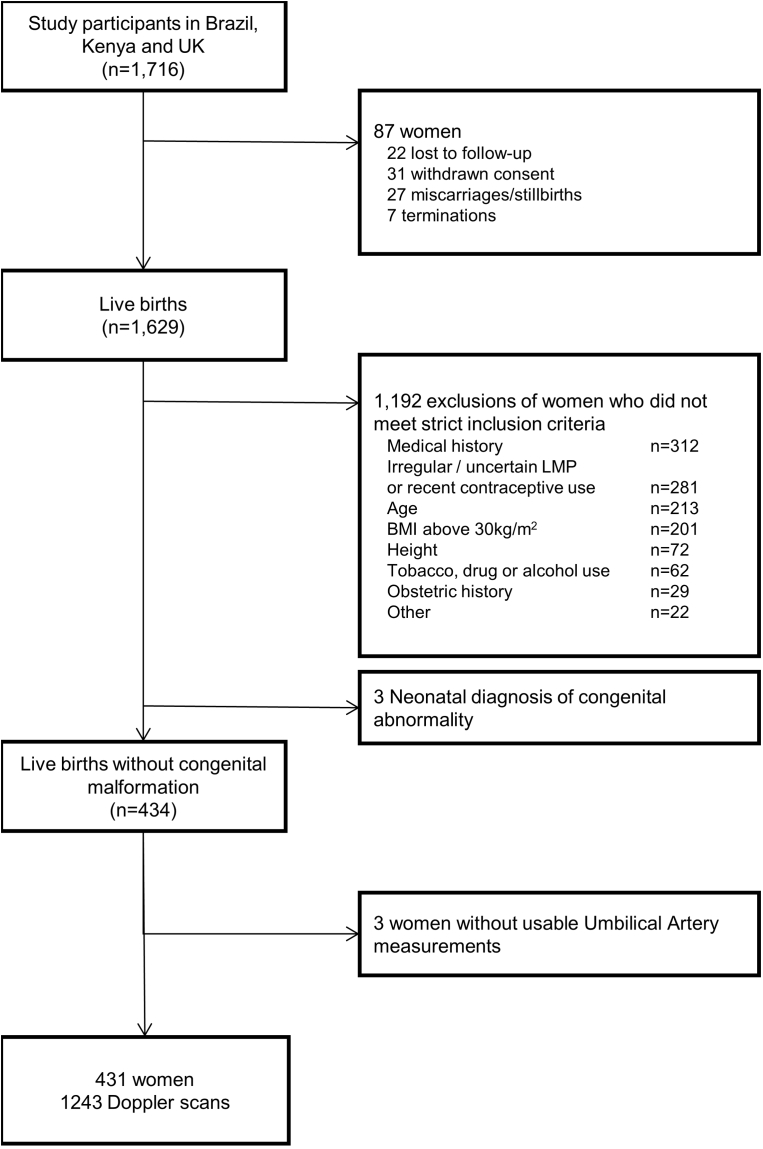
Flow chart of participants in the studyDrukker et al. International gestational age-specific centiles for umbilical artery Doppler indices: a longitudinal prospective cohort study of the INTERGROWTH-21st Project. Am J Obstet Gynecol 2020.